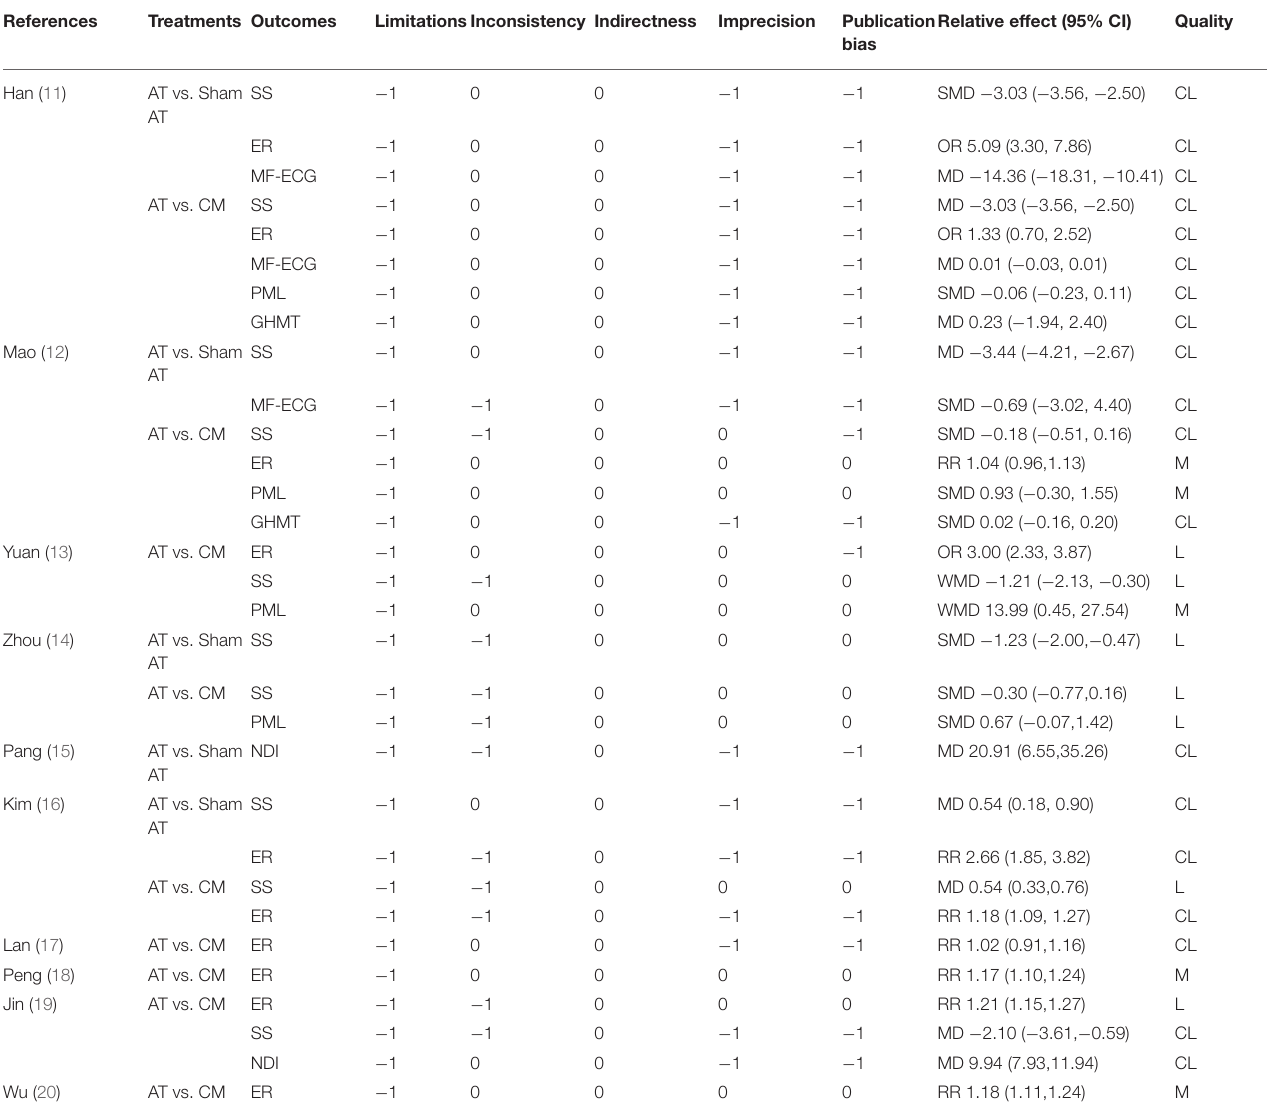
TABLE 4 | Results of evidence